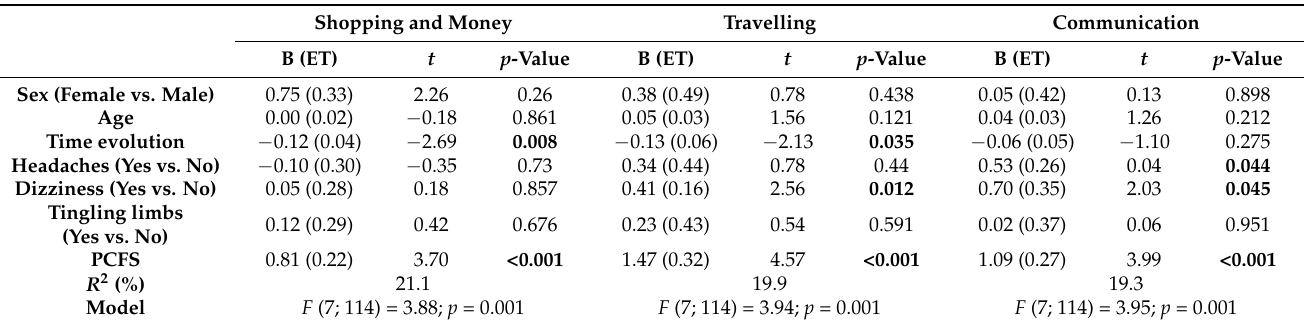
Table 5. Effect of demographic and clinical variables on the shopping and money, travel, and communication dimensions of the ADLQ